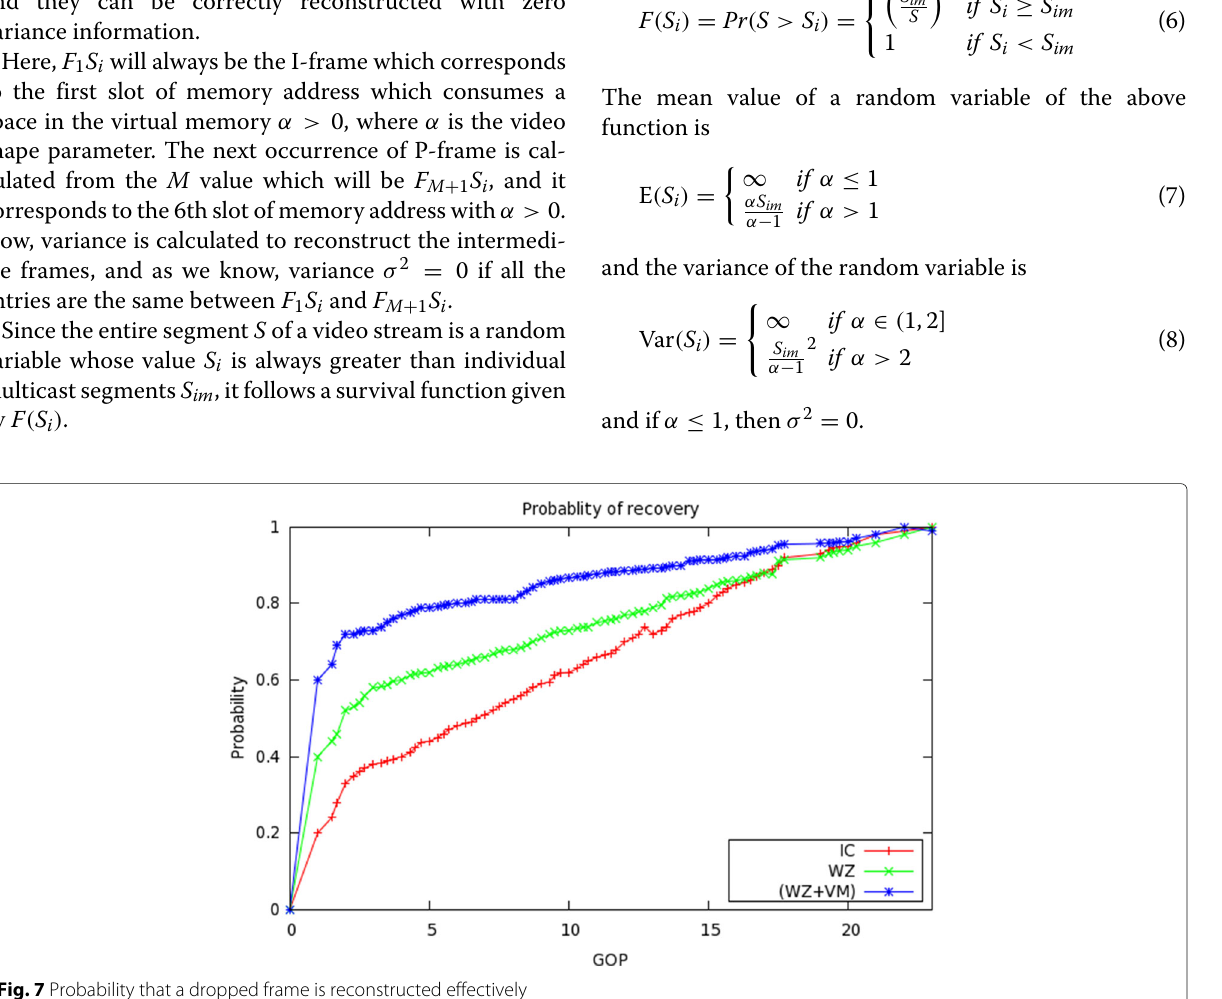
Fig. 7 Probability that a dropped frame is reconstructed